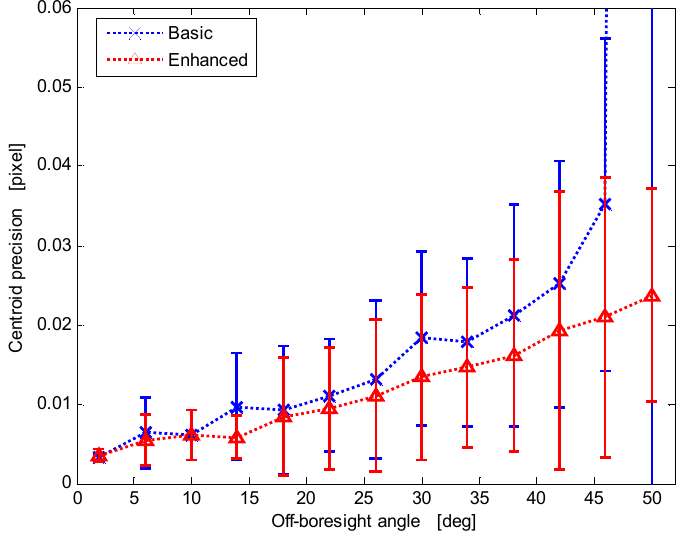
Figure 8. Centroid precision versus the off-boresight angle for the basic and enhanced